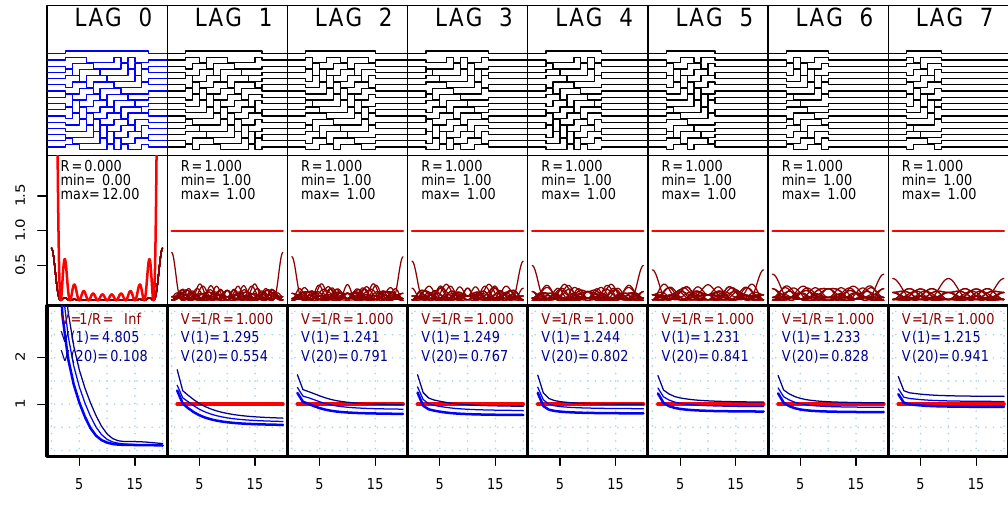
Fig. 6. A 12-bit weak alternating code set. Some differences to the strong set are visible. While slightly (but insignificantly) worse than the strong set in case of no range integration, in some cases the integration behaviour is actually better.